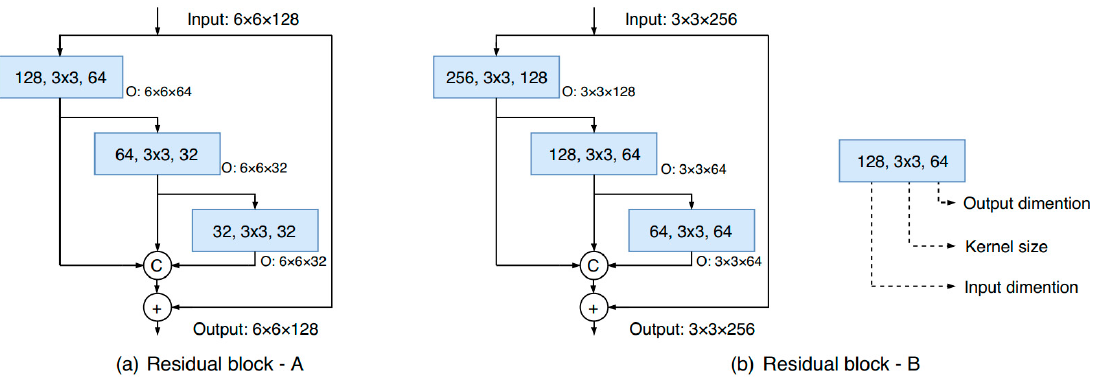
Figure 4. Architecture of Residual block-A and Residual block-B in the HSI branch. O: Output; C: Concatenate; +: